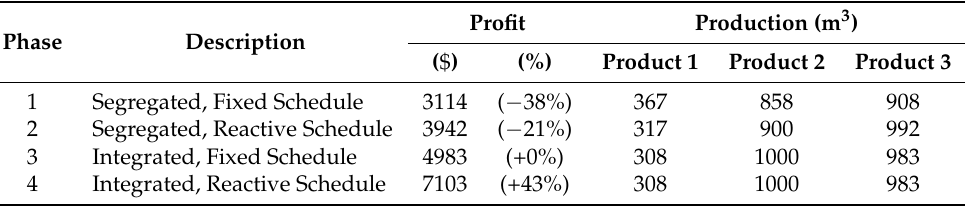
Table 7. Results: Scenario A.